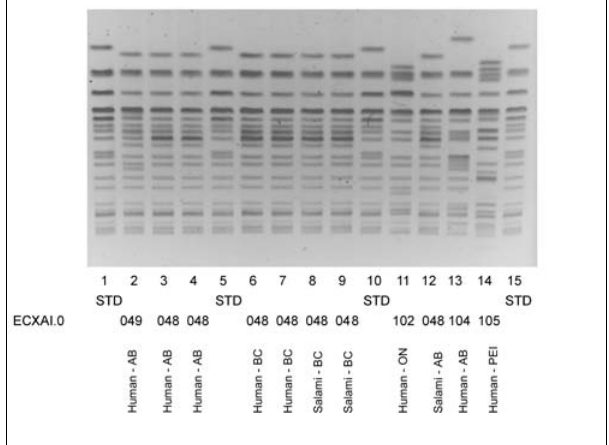
Figure 4) Pulsed-field gel electrophoresis (PFGE) of the Escherichia coli O157:H7 outbreak associated with salami that affected three provinces in Canada. Lanes 1, 5, 10 and 15 contain PFGE standard strain G5244. PFGE pattern designations and sources of the strains are shown below each